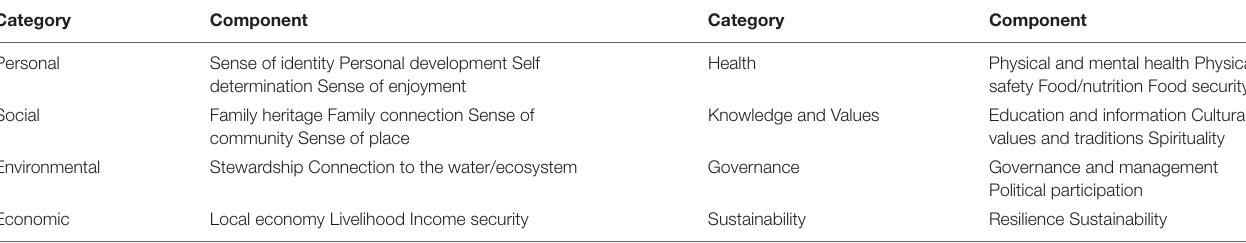
TABLE 2 | Well-being categories and components associated with fisheries participation from the